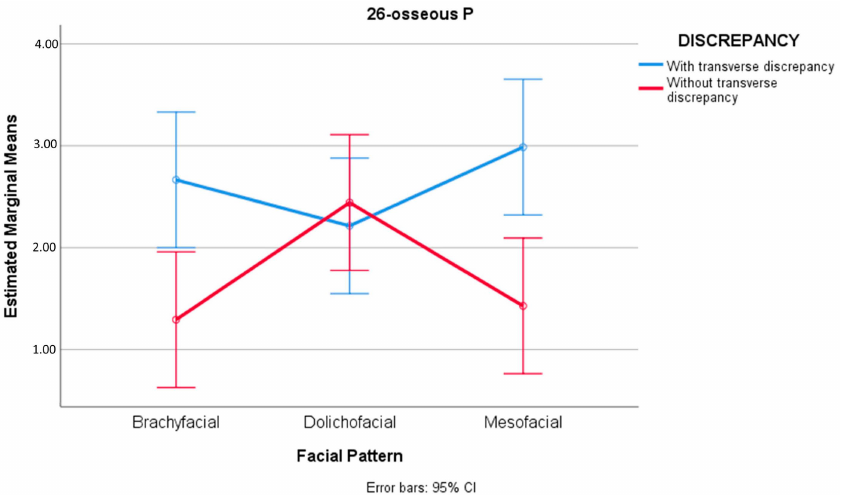
Figure 6. Transverse bone discrepancy inverts the behavior of the distance for the palatine root of the right upper first molar between patterns; in the absence of transverse bone discrepancy, the dolichofacial values tend to be greater than in the rest of the facial patterns, while in the presence of transverse bone discrepancy, the dolichofacial values are lower than in the rest of the